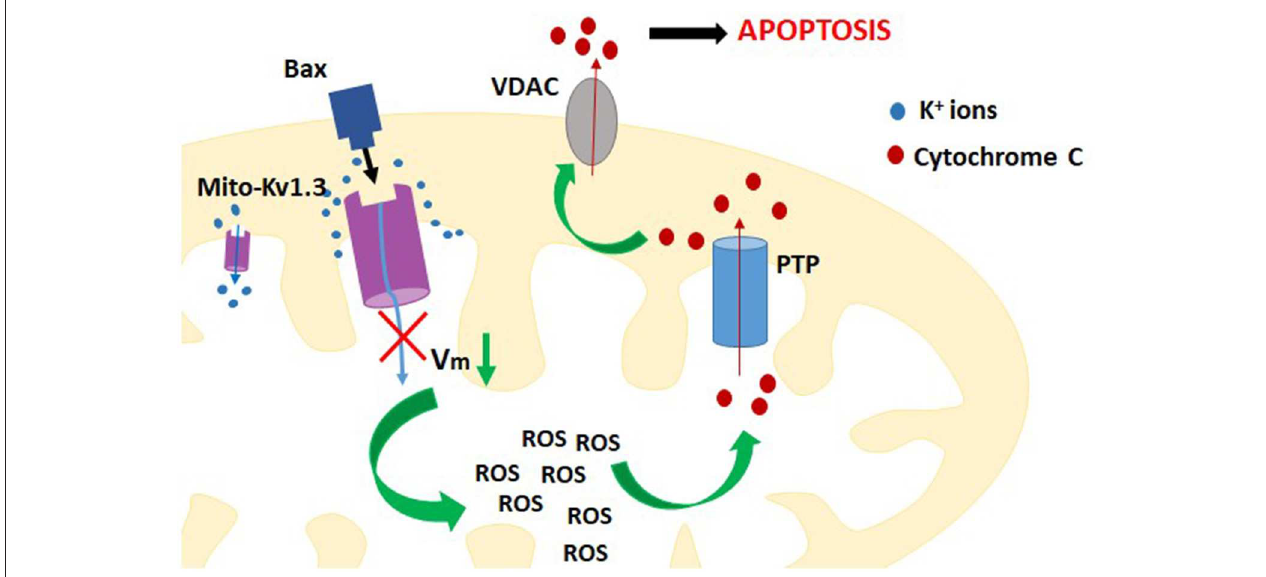
FIGURE 3 | A scheme of the contribution of inhibition of mito-Kv1.3 channel to activation of intracellular (mitochondrial) pathway of apoptosis of Kv1.3 channel expressing cells.